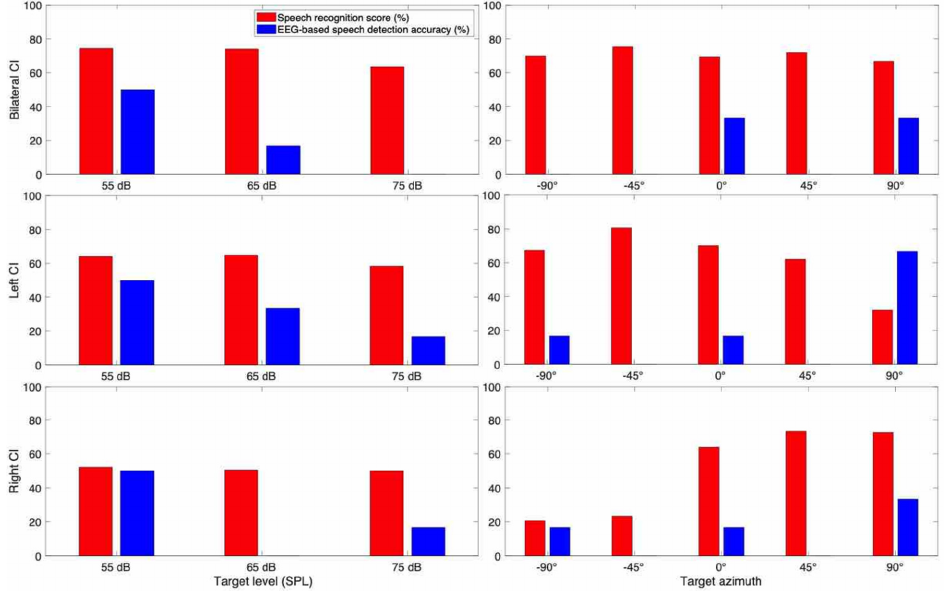
Figure 7. Speech recognition score and speech detection accuracy from EEG for CI 3.